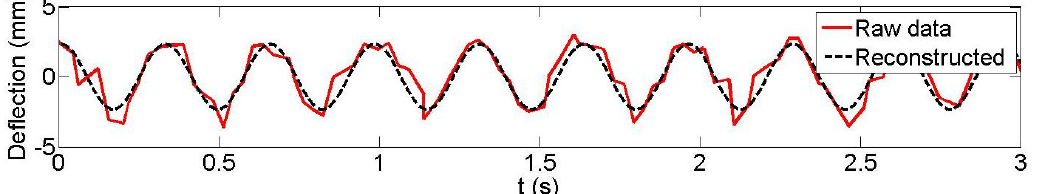
Figure 9. Kinect observed and reconstructed vertical displacements ( = 3 Hz), dataset 2 witness plate 7.